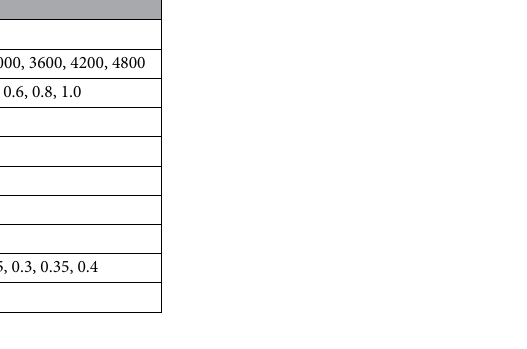
Table 2. Machining parameters of ECFG.